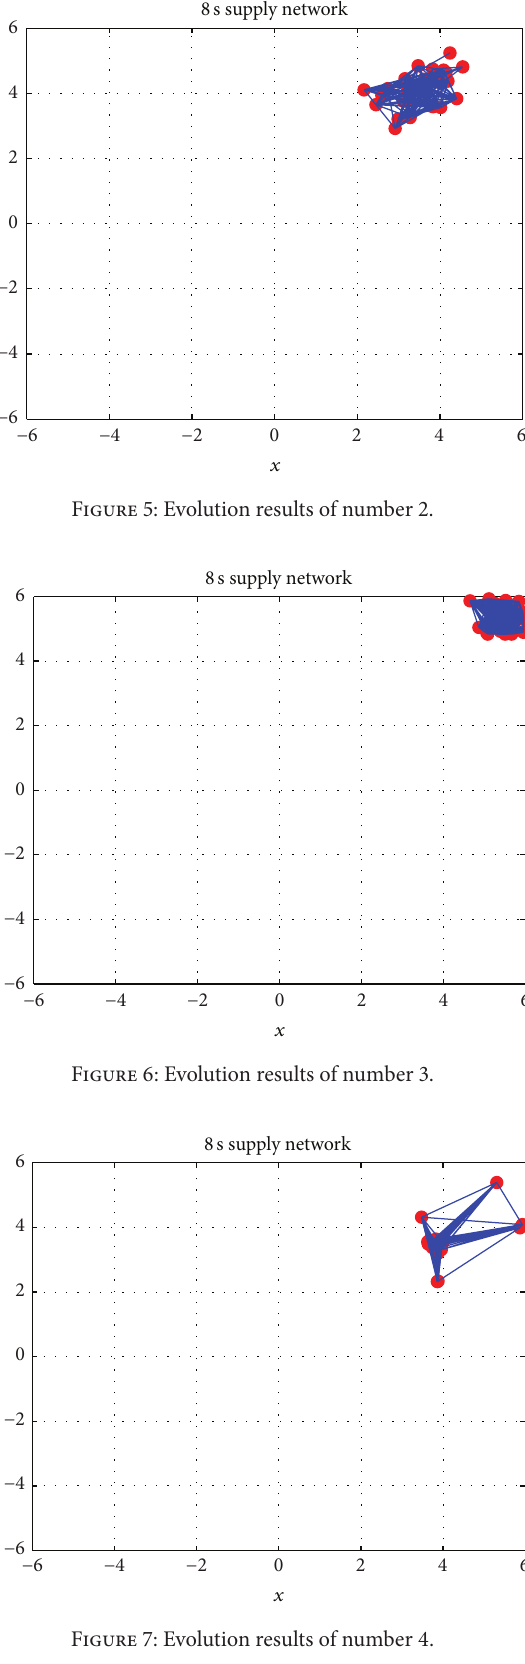
Figure 7: Evolution results of number 4.